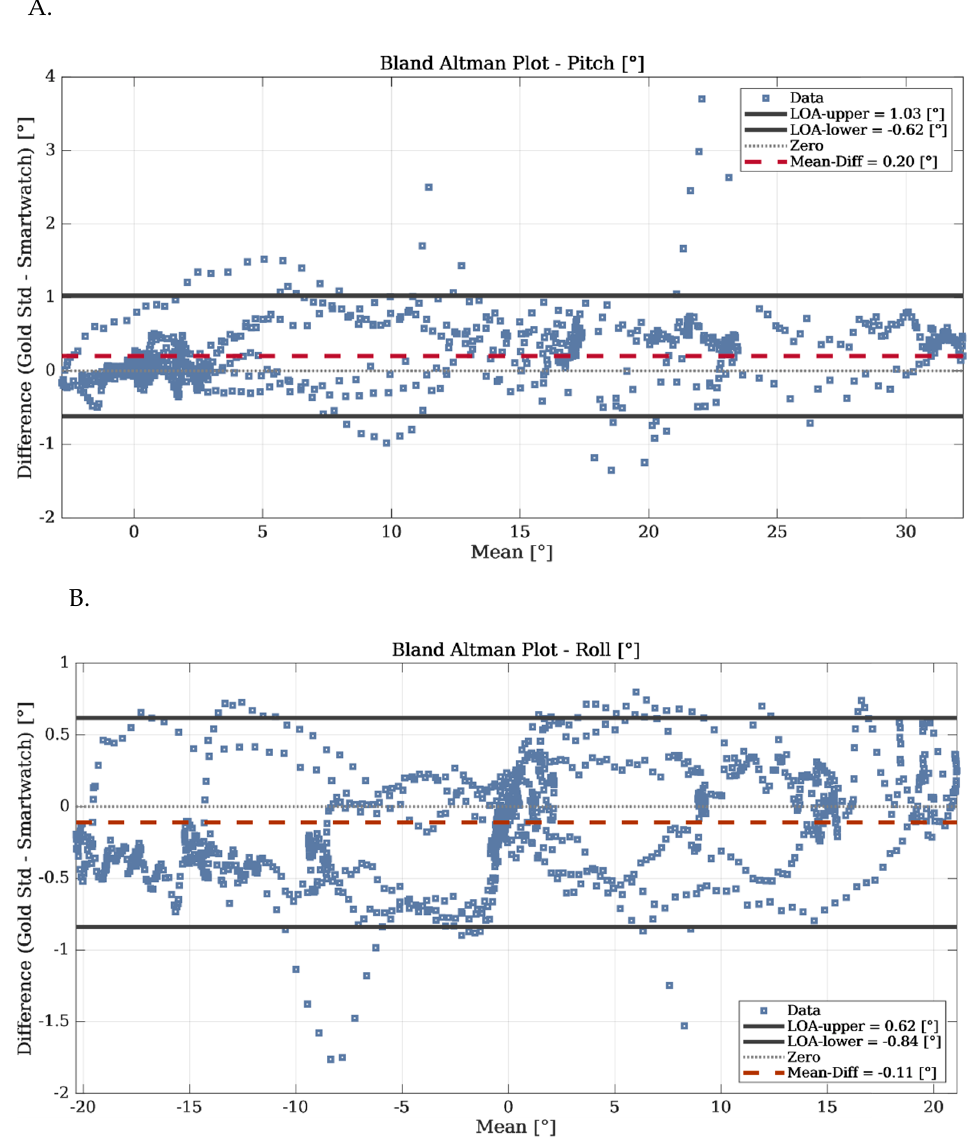
Figure 12. Bland–Altman plots illustrating differences for ( A ). the pitch and ( B ). the roll angles, estimated with our SW real-time algorithm and the built-in rotation vector sensor in the Android Samsung Galaxy M31s.